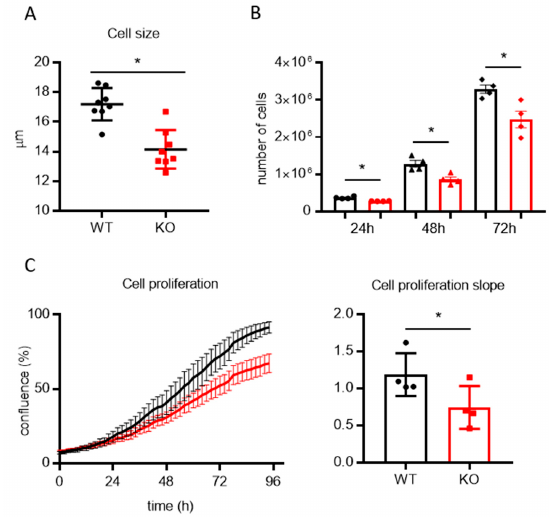
Figure 2. Lack of TMBIM5 causes a reduction of cell size and proliferation rate. ( A ) Cell size of live cells quantitated using an automated cell counter. Graph shows individual data points and the mean ± SEM. * p < 0.001 (paired t -test) ( B ) Proliferation rate of 250,000 cells seeded and counted after the indicated time. Graphs show individual data points and the mean ± SEM. * p < 0.05. ( C )